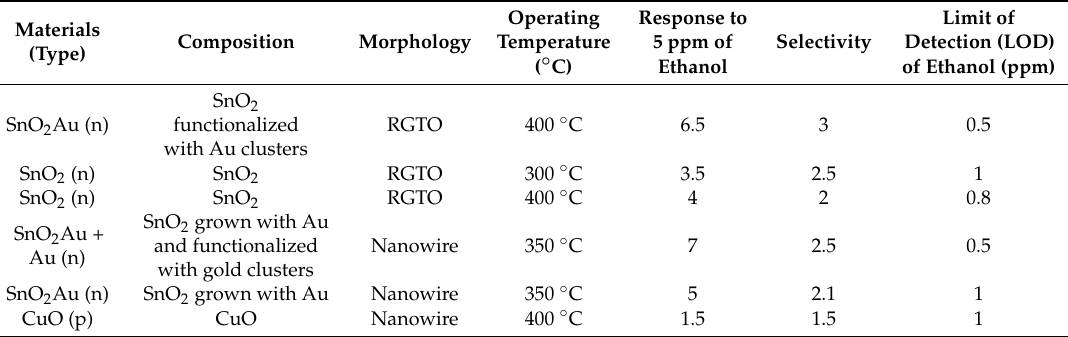
Table 1. Type, composition, morphology, operating temperature, response ( ∆ R/R), selectivity (response ethanol/response carbon monoxide) and limit of detection (LOD) of ethanol for S3 sensors made at the SENSOR